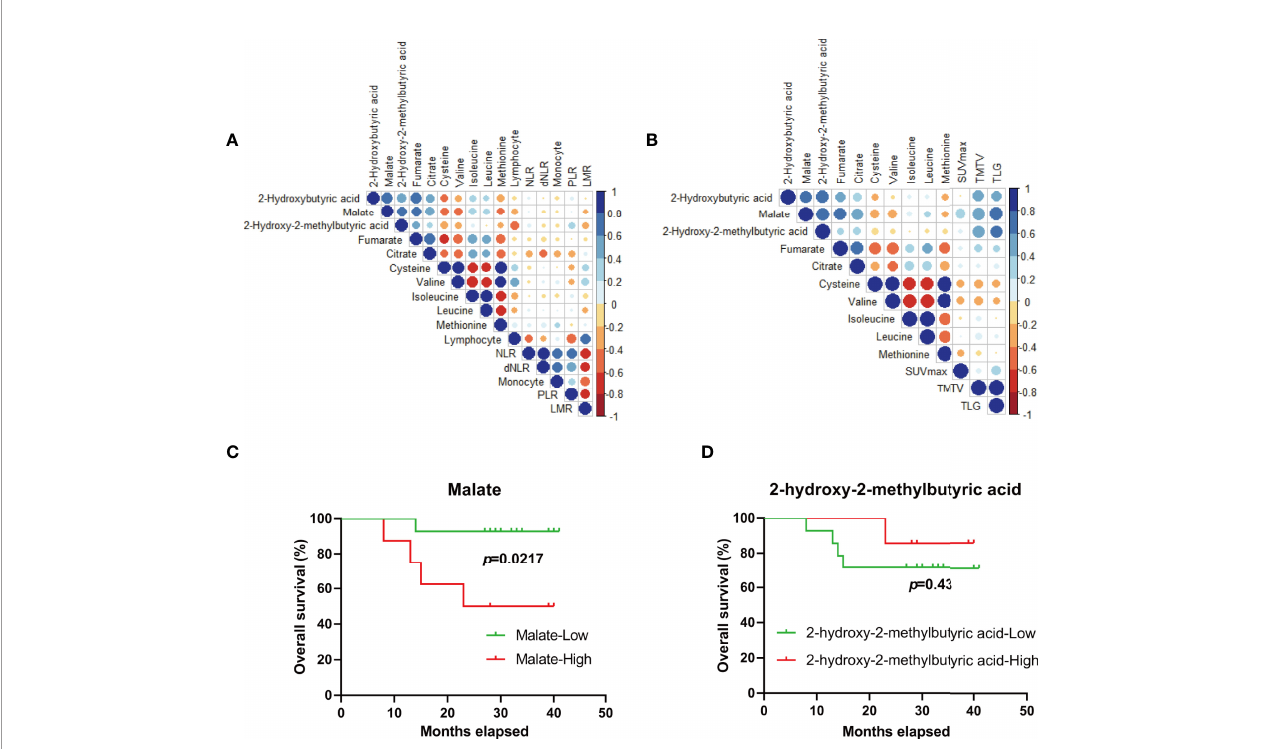
FIGURE 4 | Metabolic biomarkers for outcome-prediction of DLBCL patients. (A, B) Pearson ’ s correlation coef fi cient between candidate metabolites and potential outcome-predictive indexes including biochemical parameters (A) and tumor metrics derived from FDG-PET/CT (B) in the clinic. (C, D) The survival of DLBCL patients according to malate (C) and 2-hydroxy-2-methylbutyric acid (D) levels at diagnosis, respectively. Blue color represents a positive correlation while red color represents a negative correlation. NLR, neutrophil/lymphocyte ratio; dNLR, derived neutrophil/lymphocyte ratio; PLR, platelet/lymphocyte ratio; LMR, lymphocyte/ monocyte ratio; SUVmax, tumor maximum standardized uptake value; TMTV, metabolically active tumor volume; TLG, total lesion